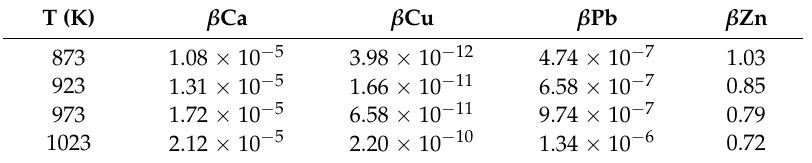
Table 2. Separation coefficients between Mg and impurities at different temperatures [23]. T (K) β Ca β Cu β Pb β